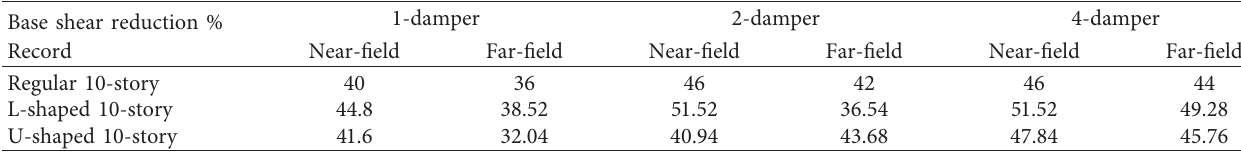
Table 10: Maximum base shear reduction percentage in the regular and irregular 10-story models.